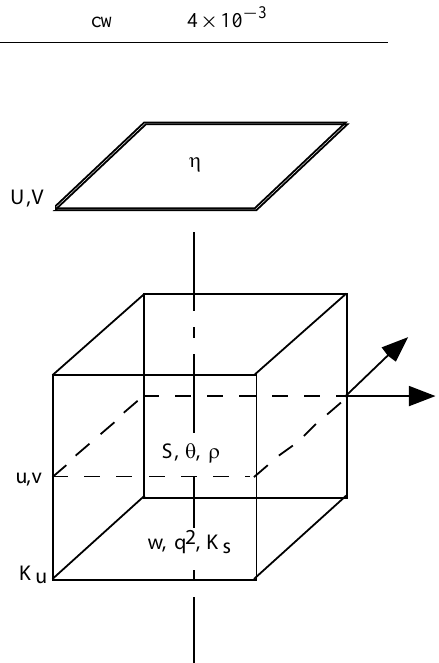
Table 2. Major parameters of CLIO. Parameters Term Value Unit Scaling factor in the computation of the Bering Strait throughflow bering 0.3 Coriolis term in the equation of motion computed in an implicit (=1) or semi-implicit way (=0.5) for the barotropic mode txicfb 1.0 Coriolis term in the equation of motion computed in an implicit (=1) or semi-implicit way (=0.5) for the baroclinic mode txifcu 1.0 Minimum vertical diffusivity for scalars avkb Minimum vertical viscosity Coefficient of isopycnal diffusion Horizontal diffusivity for scalars Horizontal viscosity Conservation (1) or not (0) of the volume of the ocean, whatever the freshwater forcing applied First bulk-rheology parameter in sea-ice rheology Creep limit used in sea-ice rheology